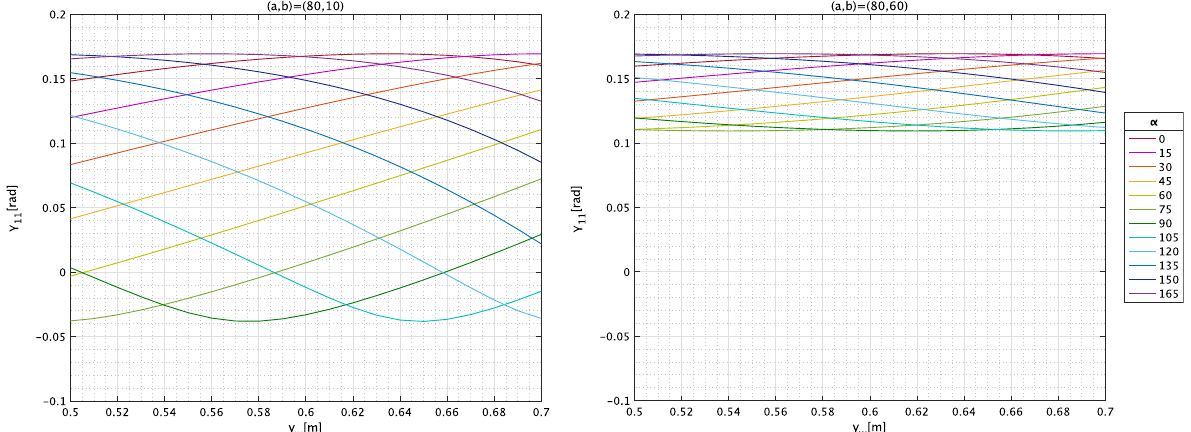
Fig. 7 Comparison of the relationship between the waist height y w and γ 11 for different a , b , and